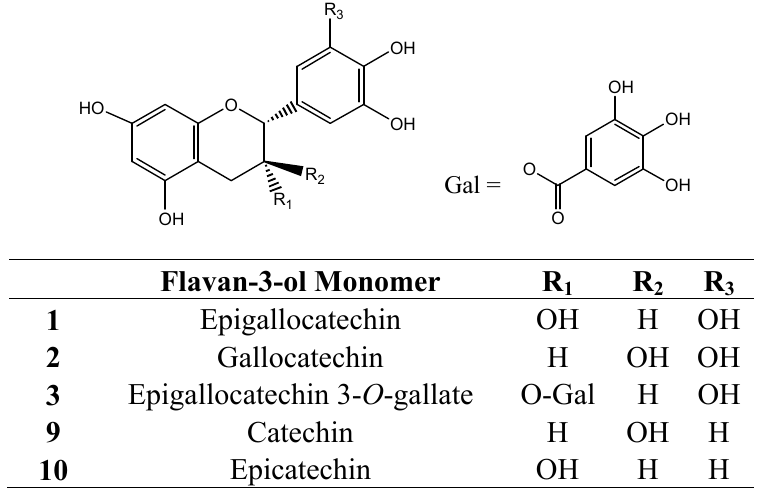
Figure 1. Structures of condensed tannin subunits (flavan-3-ol monomers)